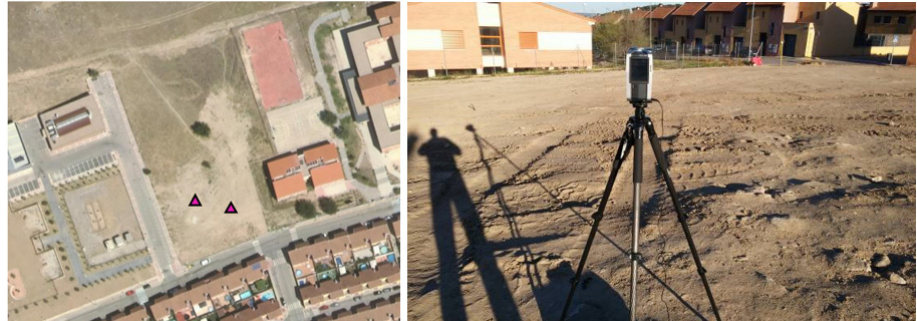
Figure 2. Positions (marked with the triangles) of the LIDAR measuring stations in the plot ( left ), and detail of the LIDAR ( right ).